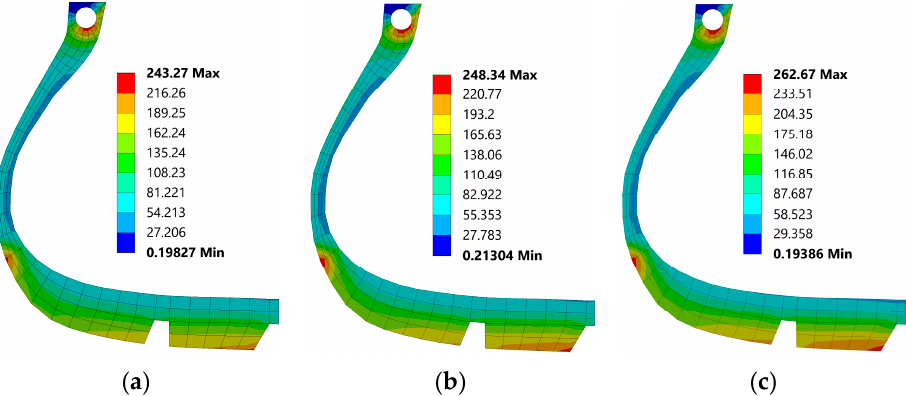
Figure 12. Distribution of heat flux in rubber with different pressures and the loading of 3 kN (unit: W/m 3 ): ( a ) 30 psi; ( b ) 32 psi; ( c ) 34 psi.